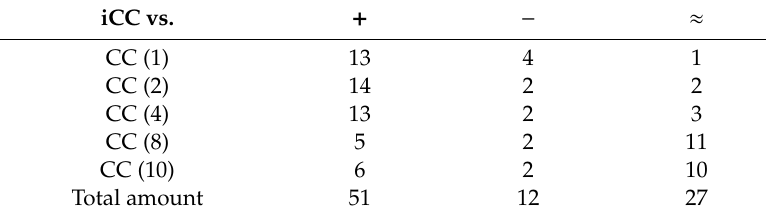
Table 4. Mann–Whitney U test, pop_size is 50.